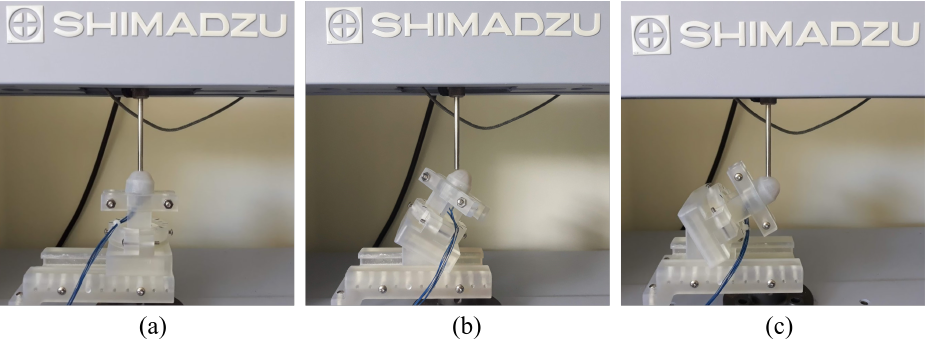
Figure 6. Calibration test setup for the multi-directional force sensor: ( a ) force along with 0 ◦ incli- nation to the vertical axis; force exerted from the different directions along with ( b ) 30 ◦ and ( c ) 60 ◦ inclination to the vertical axis.